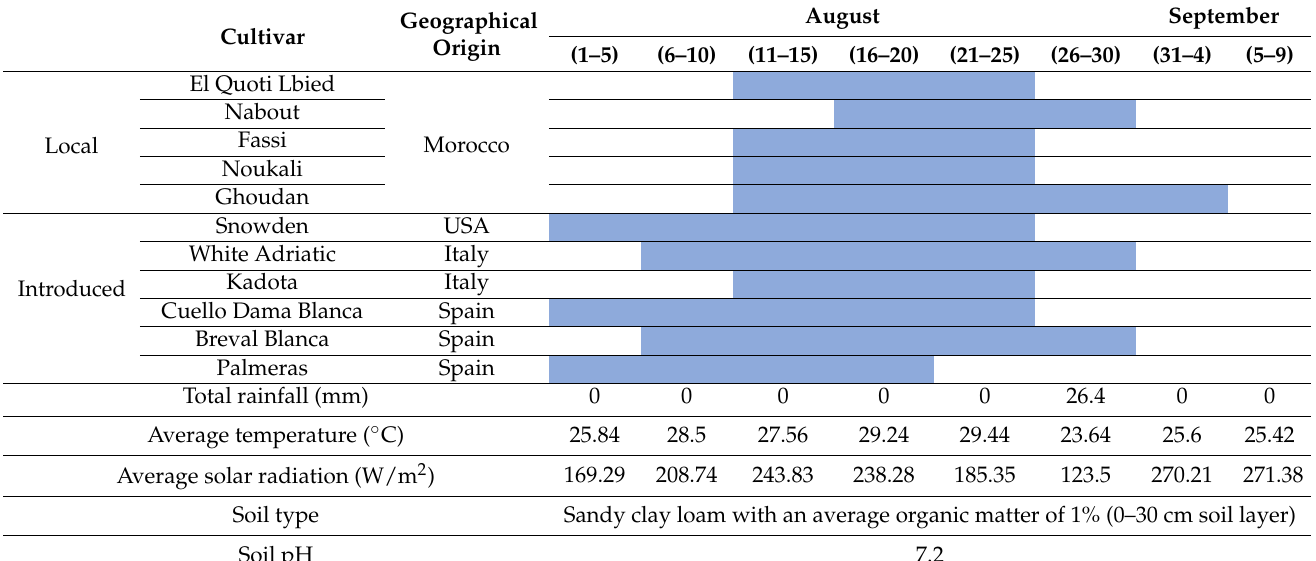
Table 1. Cultivars’ geographical origins and harvest time and monthly meteorological data from August to early September 2018 for northern Morocco, Meknes (Ain-Taoujdate experimental station—INRA).